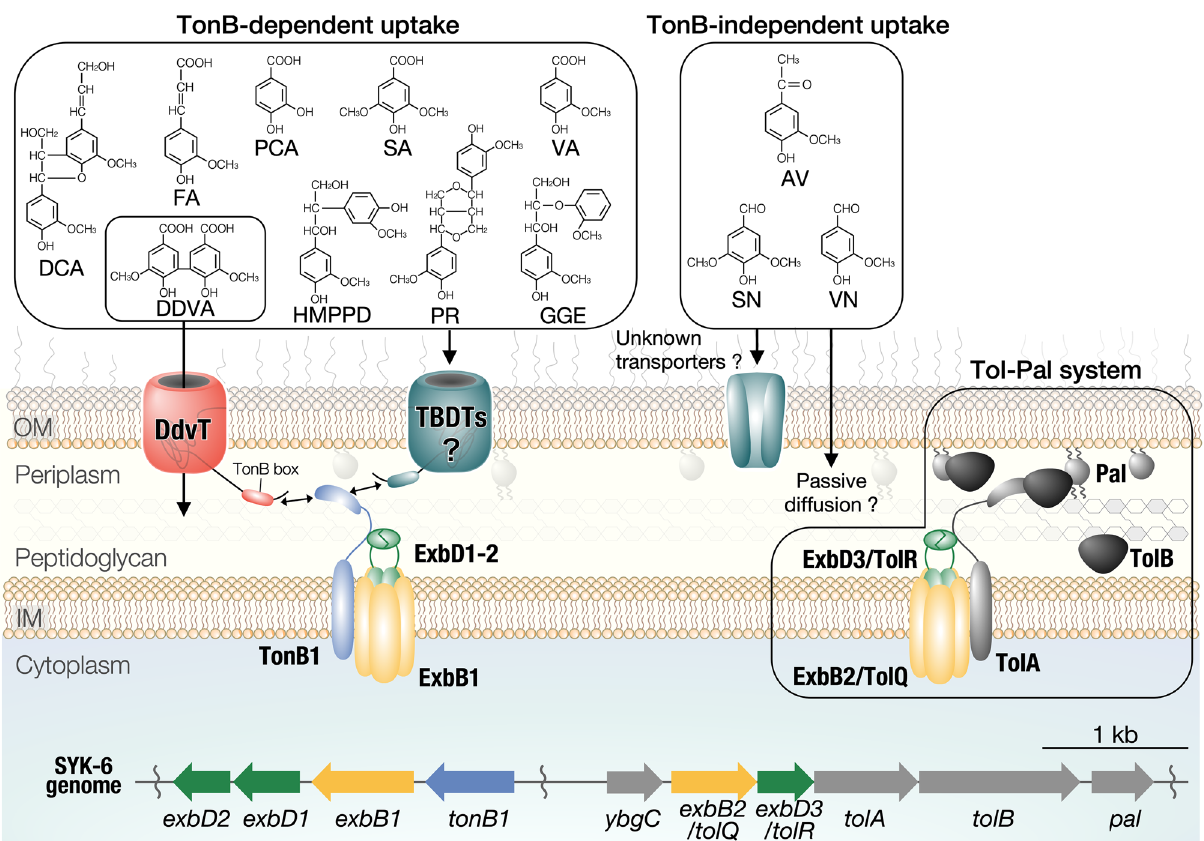
Figure 8. Proposed outer membrane transport of lignin-derived aromatic compounds in SYK-6. Outer membrane transport of GGE, PR, DCA, HMPPD, FA, VA, SA, and PCA is thought to be mediated by